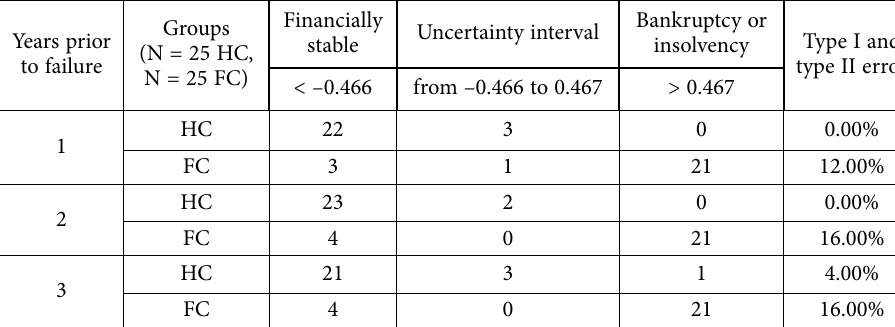
Table 10. Second sample test (source: authors’ processing) Years prior to